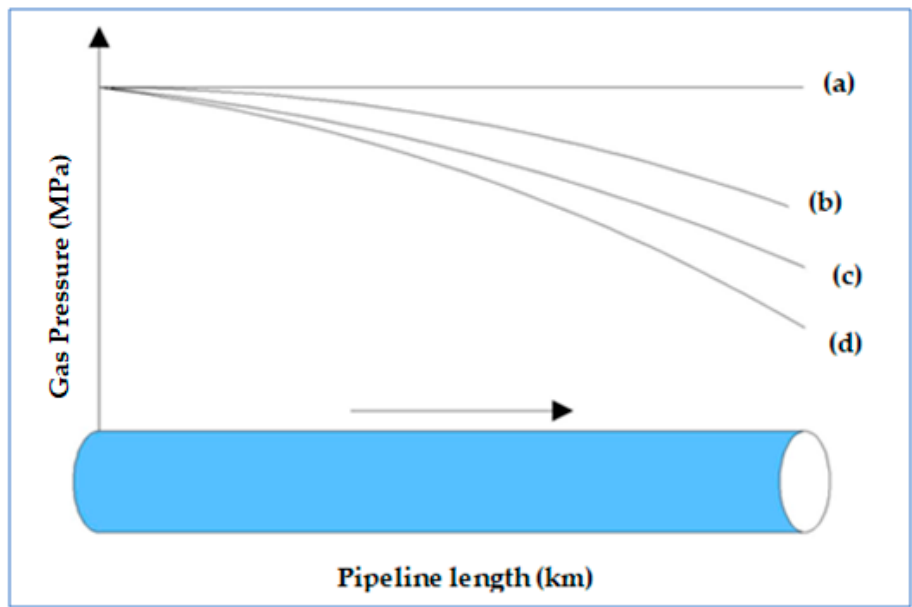
Figure 2. Gas pressure versus length ( 𝑄 (cid:4666)(cid:3028)(cid:4667) (cid:3407) 𝑄 (cid:4666)(cid:3029)(cid:4667) (cid:3407) 𝑄 (cid:4666)(cid:3030)(cid:4667) (cid:3407) 𝑄 (cid:3005) ) Figure 2. Gas pressure versus length ( Q ( a ) < Q ( b ) < Q ( c ) < Q D